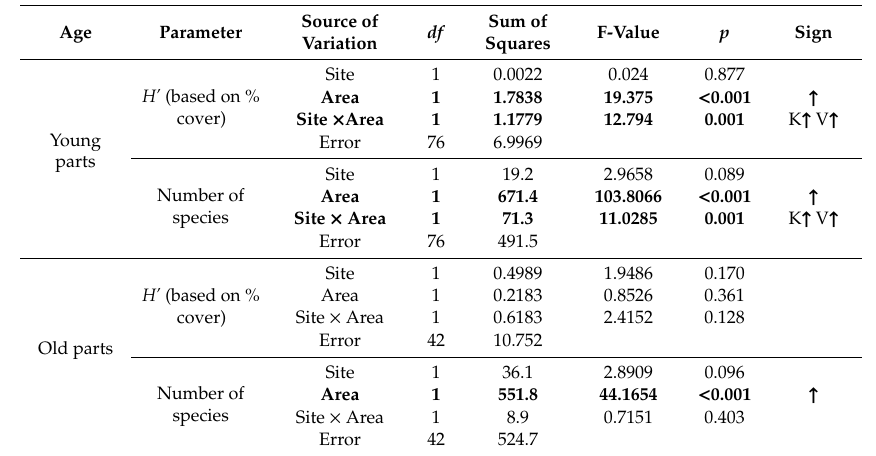
Table 6. E ff ects of plant part size (surface Area of the corresponding part, cm 2 ) and location (Sites K or V) on the number of speicies and diversity ( H’ ) on young and old plant parts of Phycodrys rubens in September 2015: type III sum of squares ANCOVAs, frames pooled. Arrows show the sign of the relationship where covariate e ff ect or interaction is significant. Significant terms are highlighted in bold.